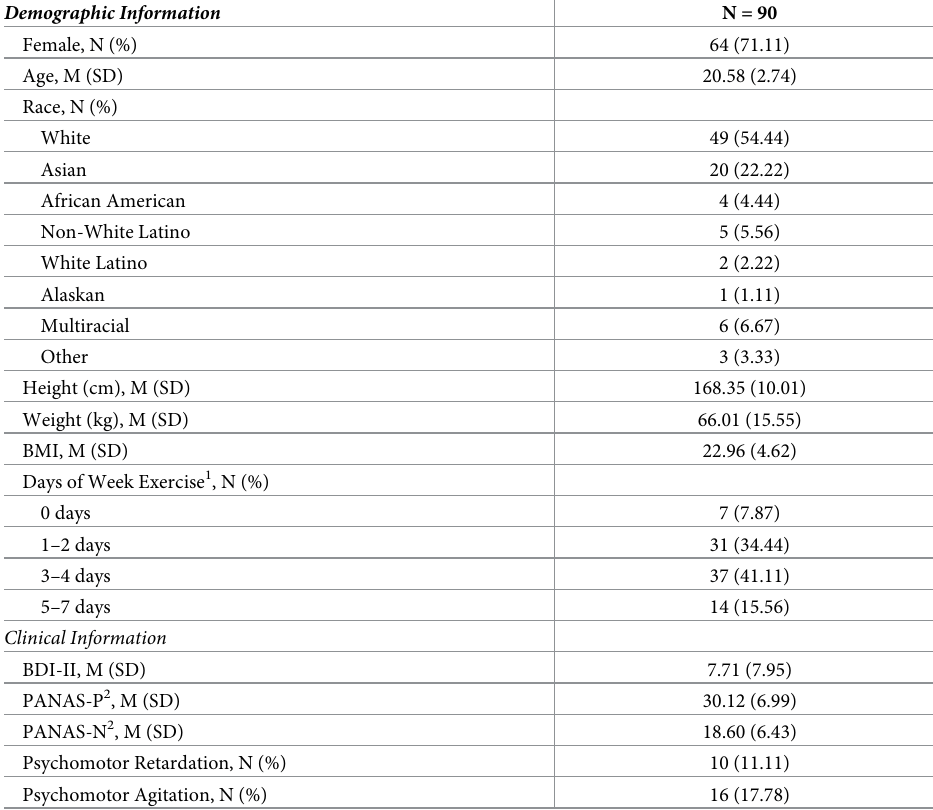
Table 1. Diagnostic and clinical characteristics of study